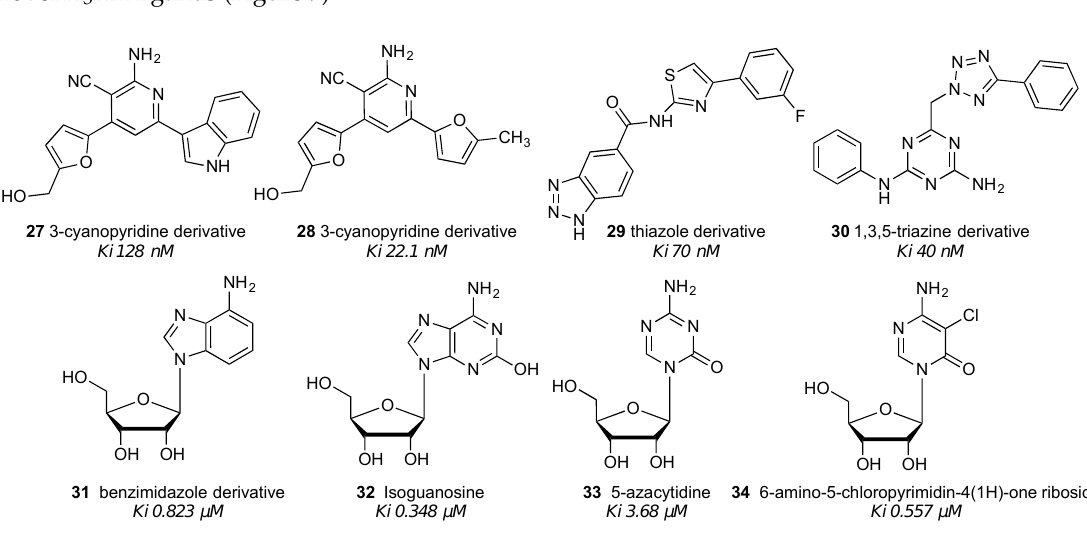
Figure 9. Structures of novel nonnucleosides ( 27 – 30 ) and nucleosides ( 31 – 34 ) found to bind to the hA 3 AR (Ki values given) as a result of structure ‐ based virtual screening (VS) [52–54].